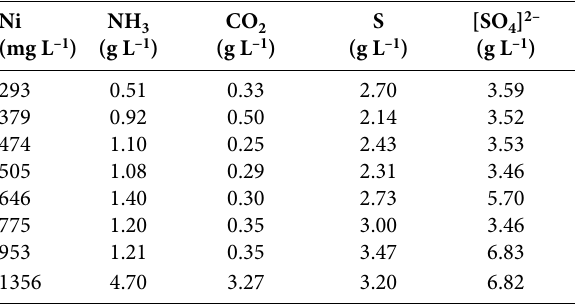
Table 1. Characterization of the liquor fed to the electrocoagulation cell